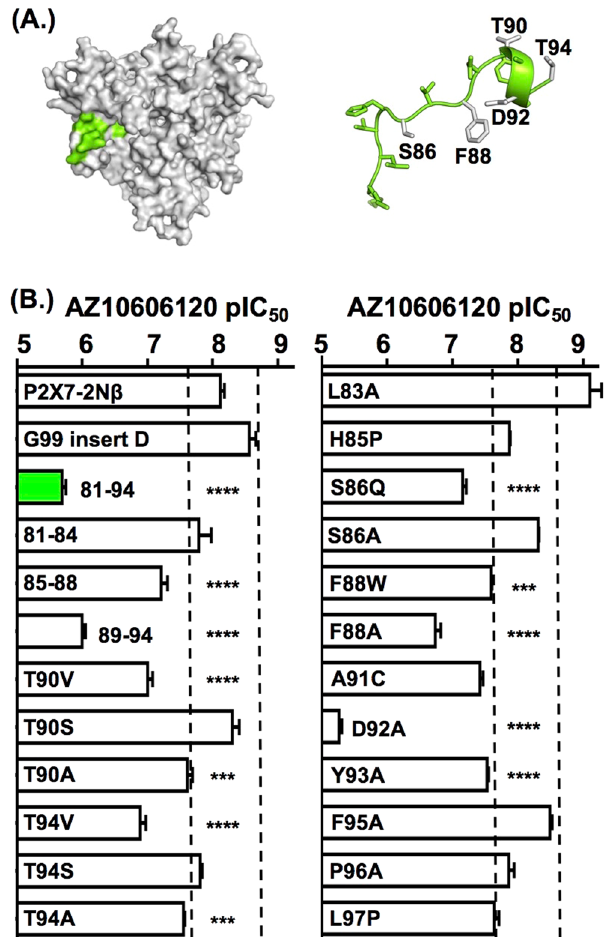
Figure 3. Contribution of variations in residues 81–94 to AZ10606120 sensitivity. ( A ) Homology model of the P2X7 receptor showing the location of the region 81–94 in one subunit, right hand panel shows cartoon and stick representation of this region (residues where mutation decreased AZ10606120 sensitivity are shown in grey). ( B ) Summary of pIC 50 values of AZ10606120 at mutant P2X7 receptors. A three-fold change from P2X7-2N β is indicated by the dotted line. Significance levels are shown on the graph only for those with > 3